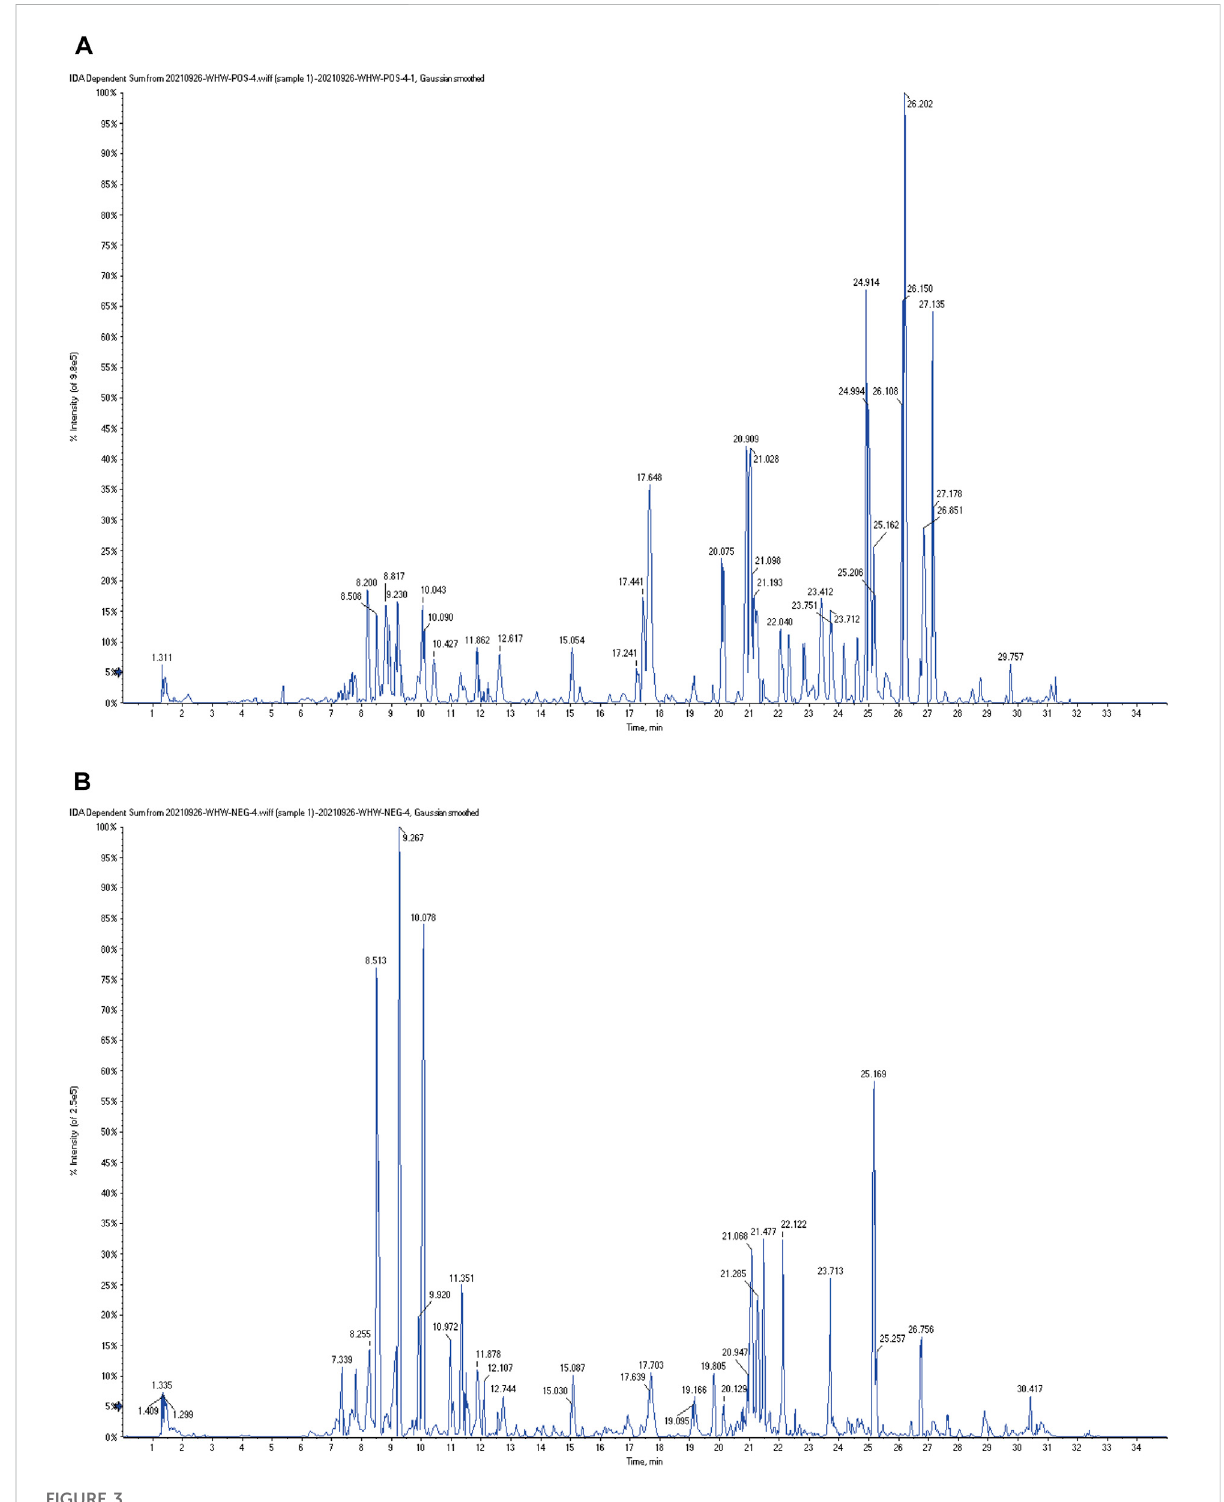
FIGURE 3 The typical total ion chromatography (TIC) pro fi les of LJAW-IAL sample (A) TIC of LJAW-IAL in positive ion mode. (B) TIC of LJAW-IAL in negative ion